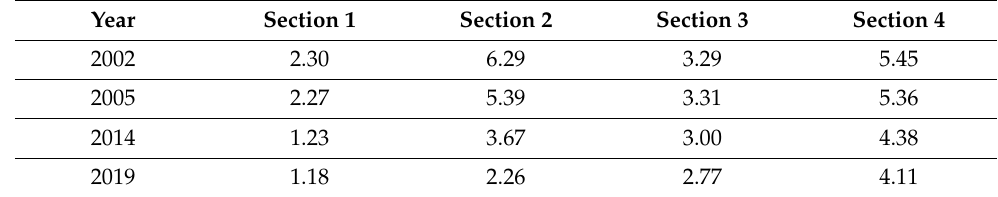
Table 2. Change of average width–depth ratio of representative sections in Oujiang